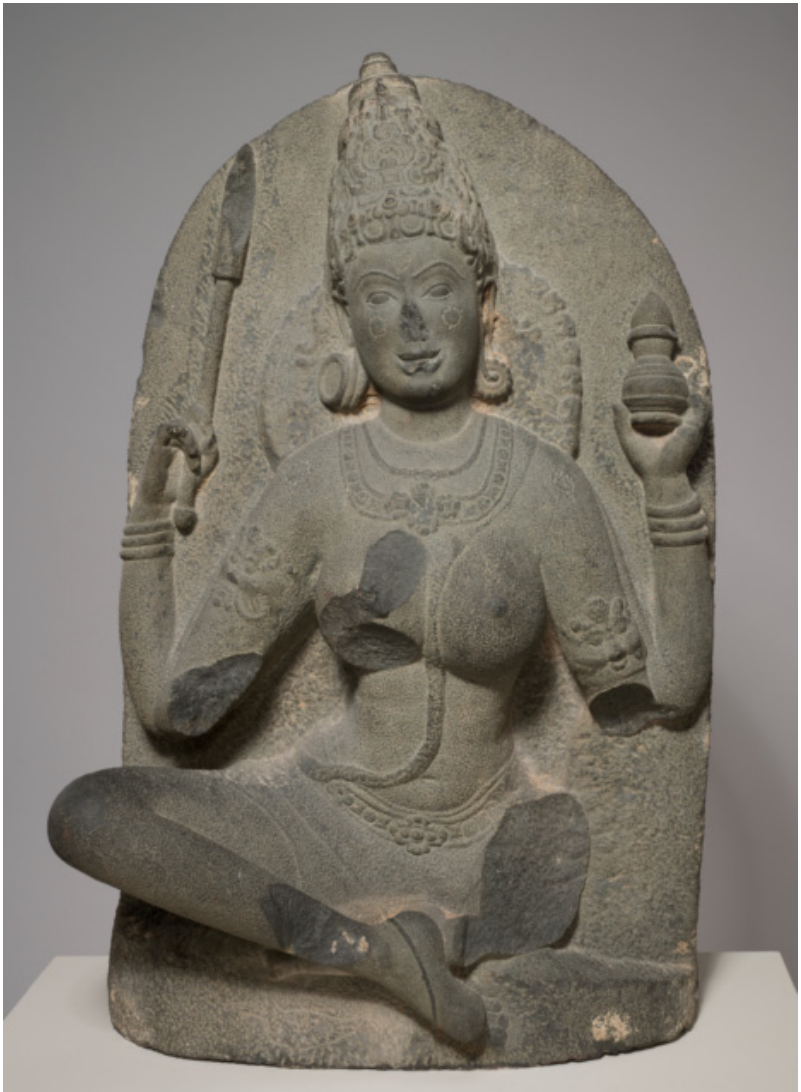
Figure 19. Yogini, Tamil Nadu, late 9th–mid-10th century: 45 × 28 1/2 × 15 1/2 in. (114.3 × 72.39 × 39.37 cm). Minneapolis Institute of Art, The Christina N. and Swan J. Turnblad Memorial Fund, 60.21. Photograph in the public domain.